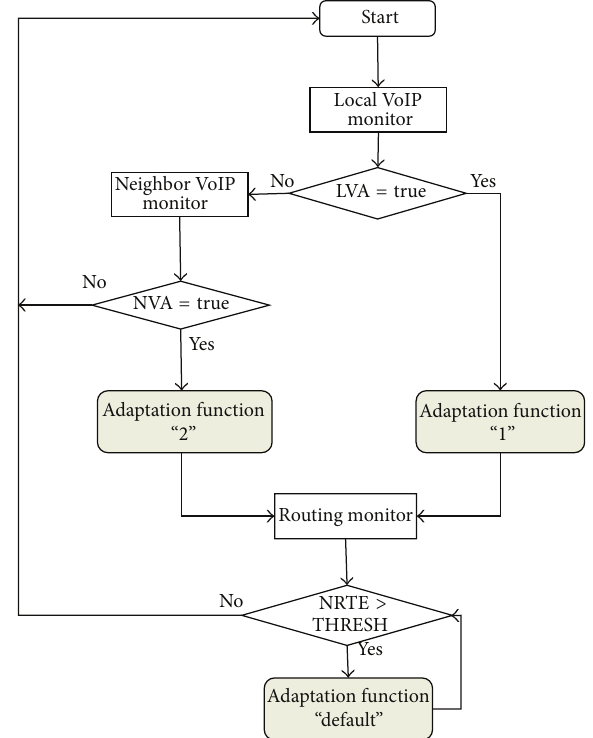
Figure 4: OLSR-VA algorithm flow